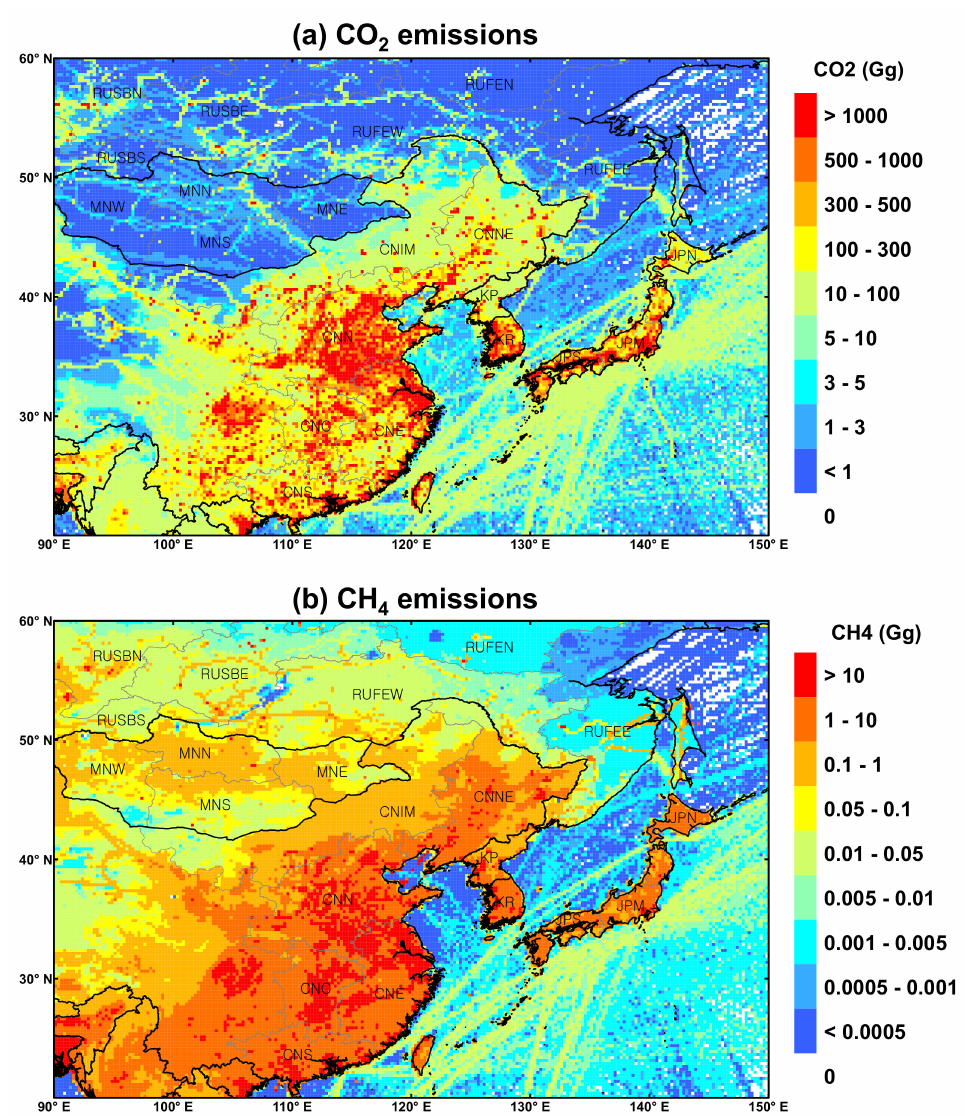
Figure A3. Spatial distribution maps of the annual total emissions for ( a ) CO 2 and ( b ) CH 4 . The CO 2 and CH 4 emissions are expressed in Gg CO 2 per 0.25 ◦ × 0.25 ◦